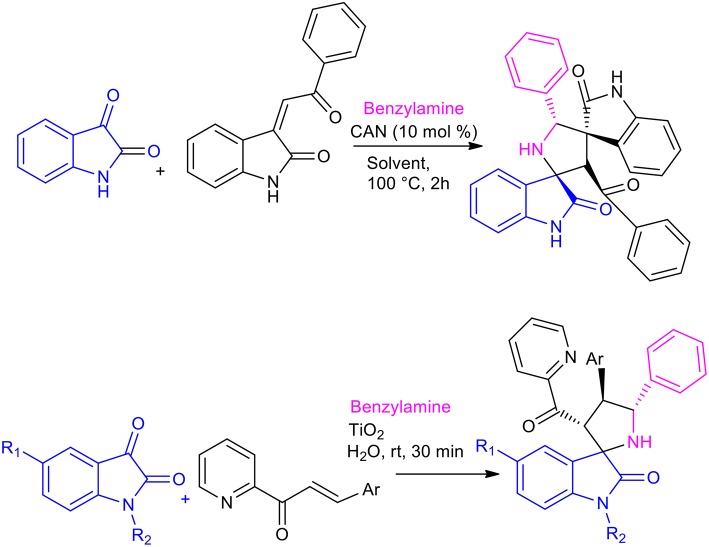
Synthesis of spiroindole by 1,3-dipolar cycloaddition with TiO2 in water and with CAN in solvent.